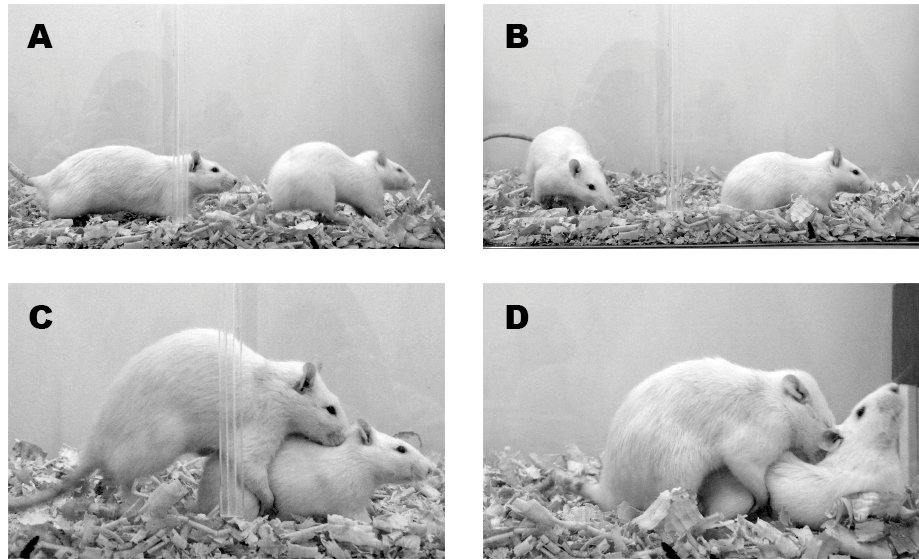
Figure 1. The images show a sequence of female proceptive behaviors that promotes male chasing (panels ( A – C )) and male mounting, with the consequent display of lordosis by the female (panel ( D